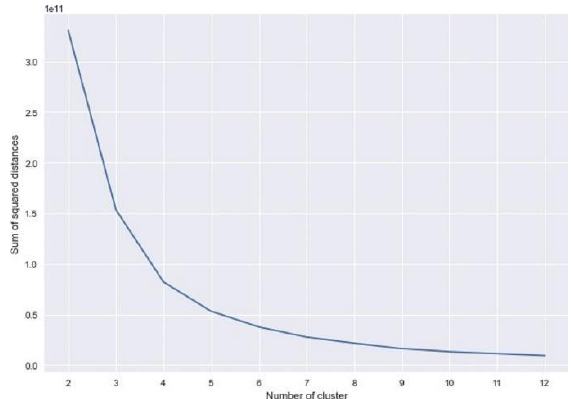
Fig 8. Elbow method of K-means clusters for Ether mining rewards.